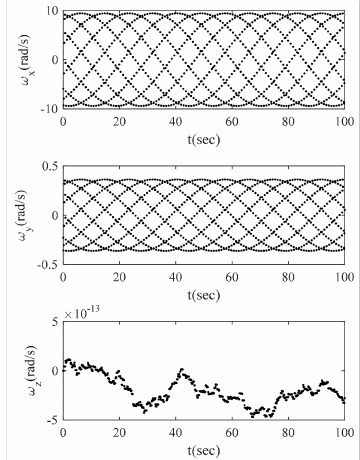
Figure 22. The angular velocity results under the complete Lie group model.